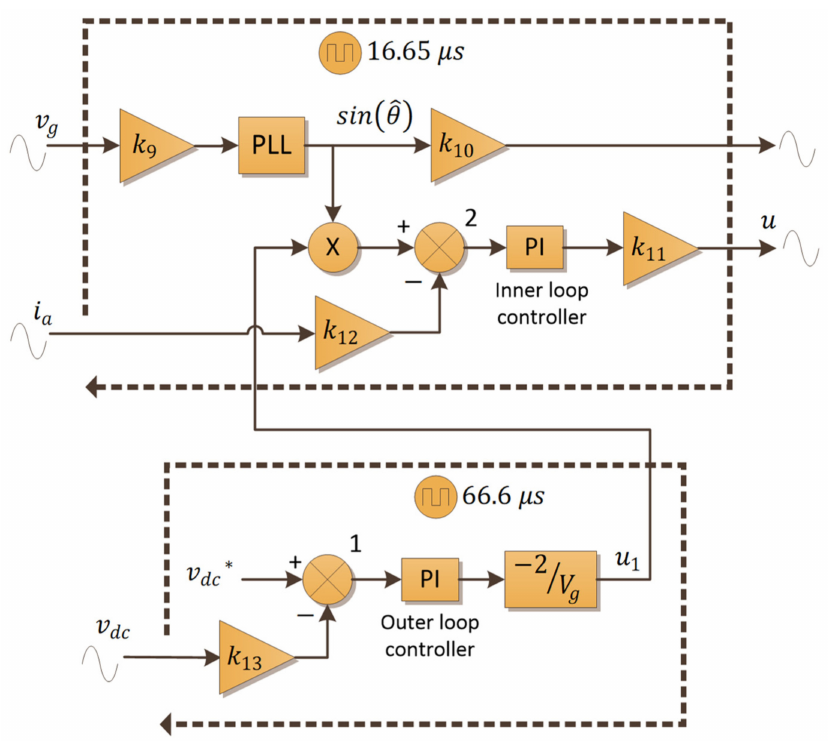
Figure 17. Control structure